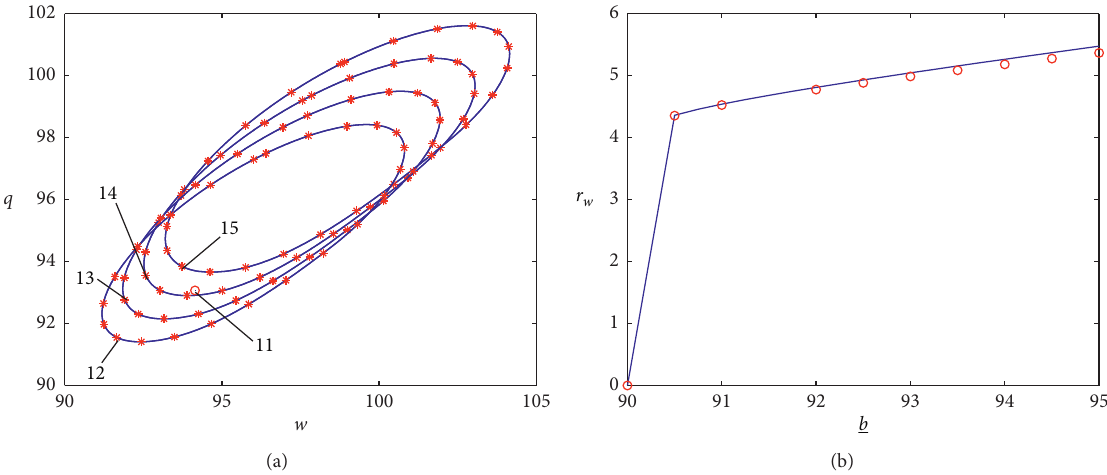
Figure 2: The phase portraits are displayed in (a) where solid blue lines are numerical results, ∗ and ° results of the HB-AFT method, and � 0 . 01 , α � 0 . 125 , β � 0 . 5 ,C � 100 ,p � 0 . 1 , and b � 450. l k � 0 . 75 ,T 1 b � 95, respectively. The comparisons of amplitudes of w in the numerical simulations and the first-order harmonic amplitudes of w by HB- AFTare presented in (b) where the solid blue line is the amplitude of numerical simulations red ° are the first-order harmonic amplitudes.